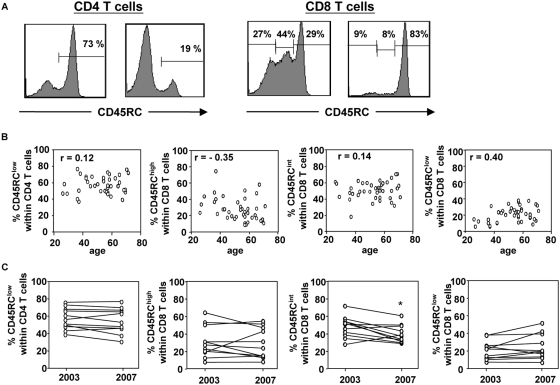
CD4 and CD8 CD45RC T cell subsets distribution in healthy individuals.Peripheral blood leukocytes from 39 healthy individuals (median age 55, range 25–70) were stained with mAbs against CD3, CD4, CD8, CD45RC. (A) The histograms represent the CD45RC expression on CD4 T cells (left panel) and CD8 T cells (right panel) from two healthy individuals showing the inter-individual variability in CD45RC expression. (B) The proportion of CD45RClow CD4 T cells (left panel) and the proportion of CD45RChigh-CD45RCint-CD45RClow CD8 T cells (right panels) are presented according to age of the donors. Each dot represents a separate individual. The r- and p-values were calculated using linear regression. (C) Represent the percentage of CD45RClow CD4 T cells (left panel) or the proportion of CD8 CD45RC T cell subsets (right panel) of 11 individuals at 4 years interval. The p-values were calculated using the Wilcoxon matched-pairs test; *, p<0.05.